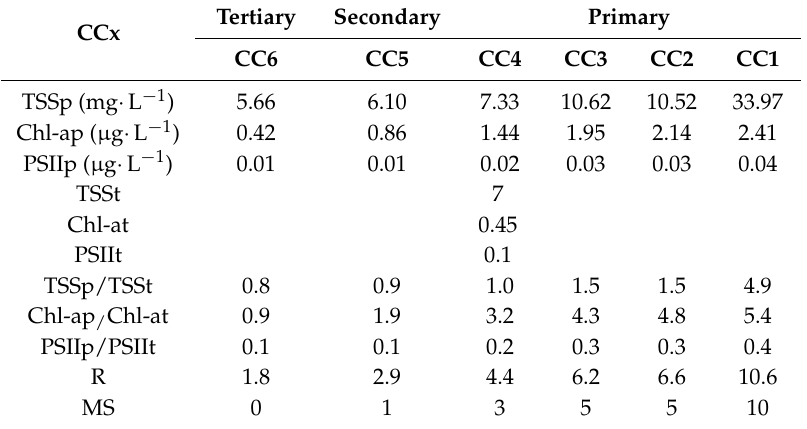
Table 2. Contaminant concentration in each plume water type (TSSp CCx , Chl-ap CCx , PSIIp CCx : Figure 5 and the supplementary material (Table S5)) is compared by ratio to published ecological threshold values for consequences and effects (TSSt CCx , Chl-at CCx , PSIIt CCx ). Ratios are summed (Equation (2): R CCx ) and normalised across all plume water types in order to calculate a Magnitude Score within each plume water type (Equation (3): MS CCx